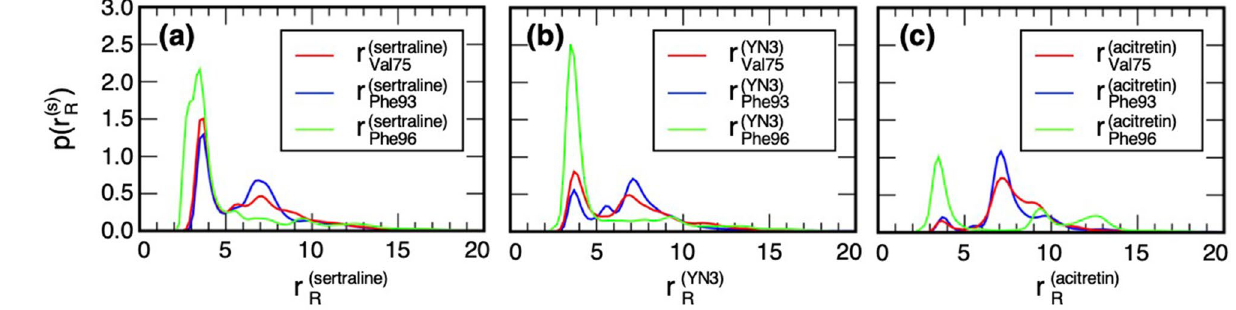
( s ) R (cid:30) for ( a ) the sertraline–mSin3B ( s = sertraline), ( b )